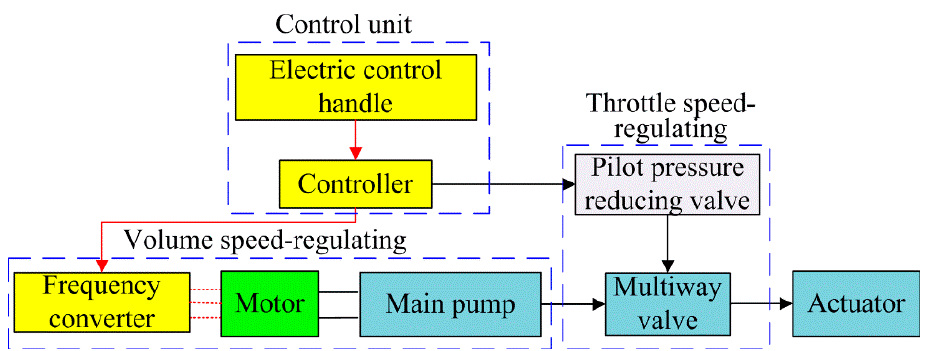
Figure 2. Control structure diagram of a PFS based on variable speed.